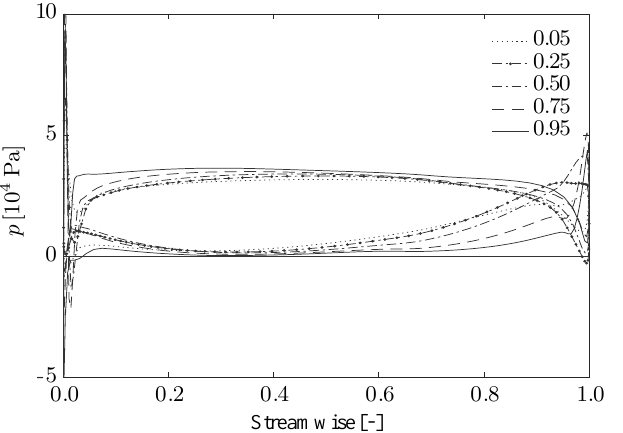
Fig. 16. Pressure on blades in pumping operation at different